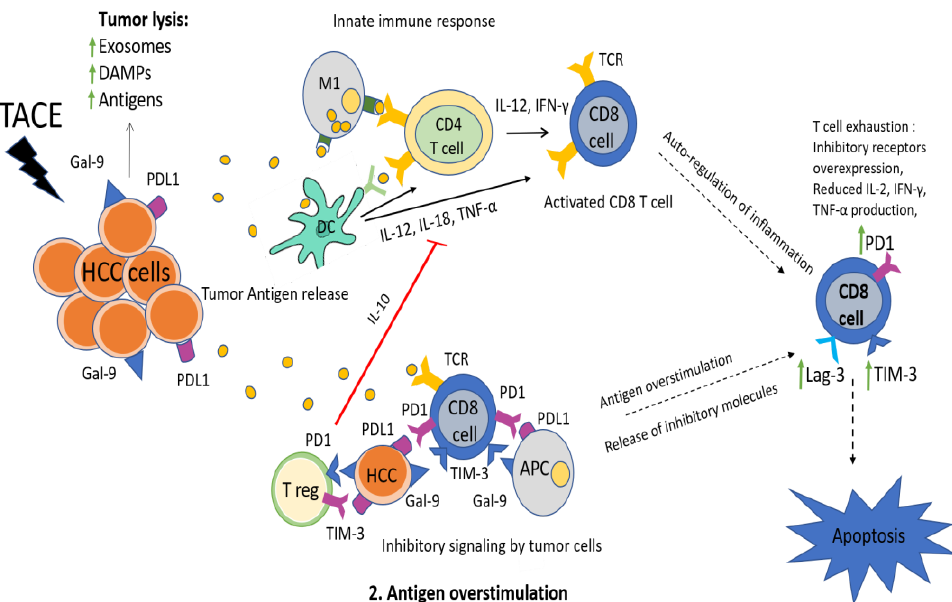
Figure 5. The “2-hit” hypothesis: ( 1 ) excessive inflammation induced by tumor lysis following TACE is autoregulated and self-restricted by expression of co-inhibitory receptors (TIM-3, PD-1, Lag-3) on T cells, ( 2 ) T-cell overstimulation by tumor-related antigens and inhibitory signaling by released tumor cells leads to T-cell exhaustion defined by poor e ff ector function and expression of co-inhibitory receptors such as PD-1 and TIM-3, upregulation of T reg cells and reduced inflammatory cytokine production. Both pathophysiological mechanisms result in increased TIM-3 expression on the surface of CD8 + T cells and eventual depletion of the anti-tumor immune response. HCC; hepatocellular carcinoma, TACE; transarterial chemoembolization, NK; natural killer, APCs; antigen presenting cells, TIM-3; T cell immunoglobulin and mucin domain-3, Lag-3;Lymphocyte-activation gene-3, PD-1; programmed death 1, PD-L1; programmed death 1 ligand, IL; interleukin, IFN- γ ; interferon- γ , TNF- α ; tumor necrosis factor-alpha, T reg; t regulatory, DC; dendritic cells, M1; macrophage, DAMPs; damage-associated molecular